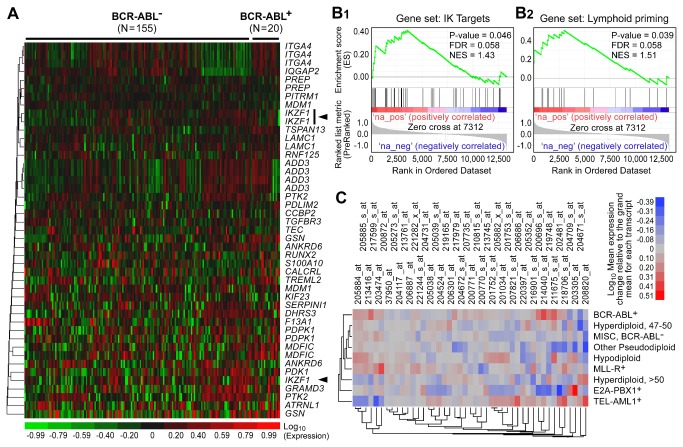
Transcript Levels of Ikaros Target Genes in Primary Leukemia Cells from Pediatric Ph- and Ph+ BPL Patients.Expression levels of IK target genes were compared for primary leukemic cells from 155 pediatric Ph-/BCR-ABL- BPL patients and 20 Ph + /BCR-ABL + /BPL patients on the Mullighan study (GSE12995). Transcript signal values were obtained from hybridization onto the Affymetrix Human Genome U133A genechip arrays. Heat map depicts up and down regulated transcripts ranging from red to green respectively for mean centered log10 transformed expression values and clustered according to average distance metric (A). Rank ordered difference in standard deviation units for Ph+ samples (N=20) compared to other samples (N=155) in the Mullighan study (GSE12995) were processed for enrichment of IK target genes (B1) and IK-regulated lymphoid priming genes (B2) using a supervised approach implemented in GSEA2.08 (Broad institute). Enrichment scores for calculated for the ranked members of the gene sets and normalized to the gene set size (NES) for which the P-value was calculated using 1000 permutations of the pre-ranked gene list and the FDR corrected for testing 2 gene sets. There was a significant enrichment of IK target genes (NES = 1.43, P = 0.046) for Ph+ patients that included the leading edge subset comprised of TSPAN13, GSN, MDFIC, ITGA4, TREML2, RNF125, IQGAP2, LAMC1, TES, DHRS3, S100A10, IL12RB1, ADD3, GRAMD3, ATRNL1, RUNX2, MCOLN3, ATP1B1, and CALCRL. Likewise, there was a significant enrichment of lymphoid priming genes (NES = 1.51, P = 0.039) for Ph+ patients that included the leading edge subset comprised of IGJ, CNN3, CD52, DNTT, CSF1R, SATB1, LTB, PTGER2, MEF2C, RUNX2 (Figure 1B.2). There was a significant increase in the multivariate mean for 45 transcripts in the Ph+ subset of specimens compared to the pooled mean of the other subsets (MANOVA, F1,173 = 11.29, P=0.001). The mean level of expression for each transcript in each BPL subset is illustrated in the heat map organized using a two-way hierarchical clustering method (average distance metric) to group expression profiles of transcripts and specimen subsets (C).